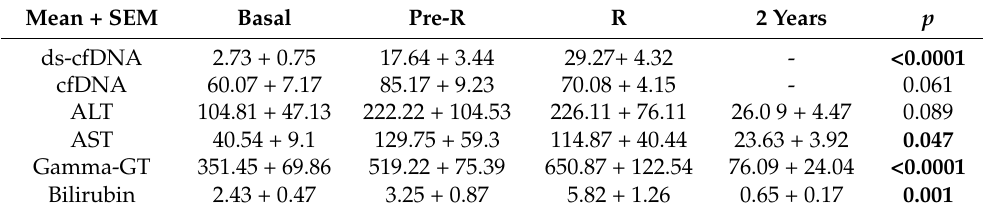
Table 2. Comparison of values of percentage of graft cfDNA and classical hepatic markers at basal, 2 years after TX, BPR, and 2 days before BPR time points.